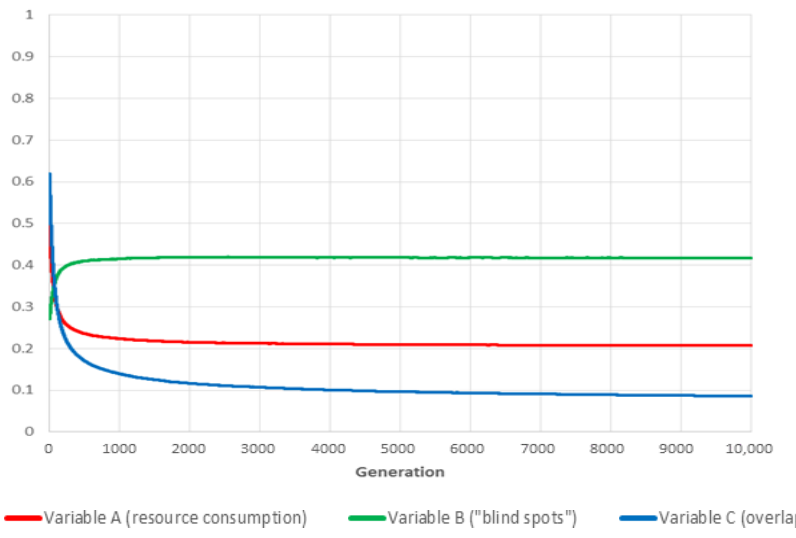
Figure 6. The curves show the evolution over time of the three global variables (for the values α = β = γ = 1 ) for the fittest individual of each generation (reported are the averaged values over 3 180 independent